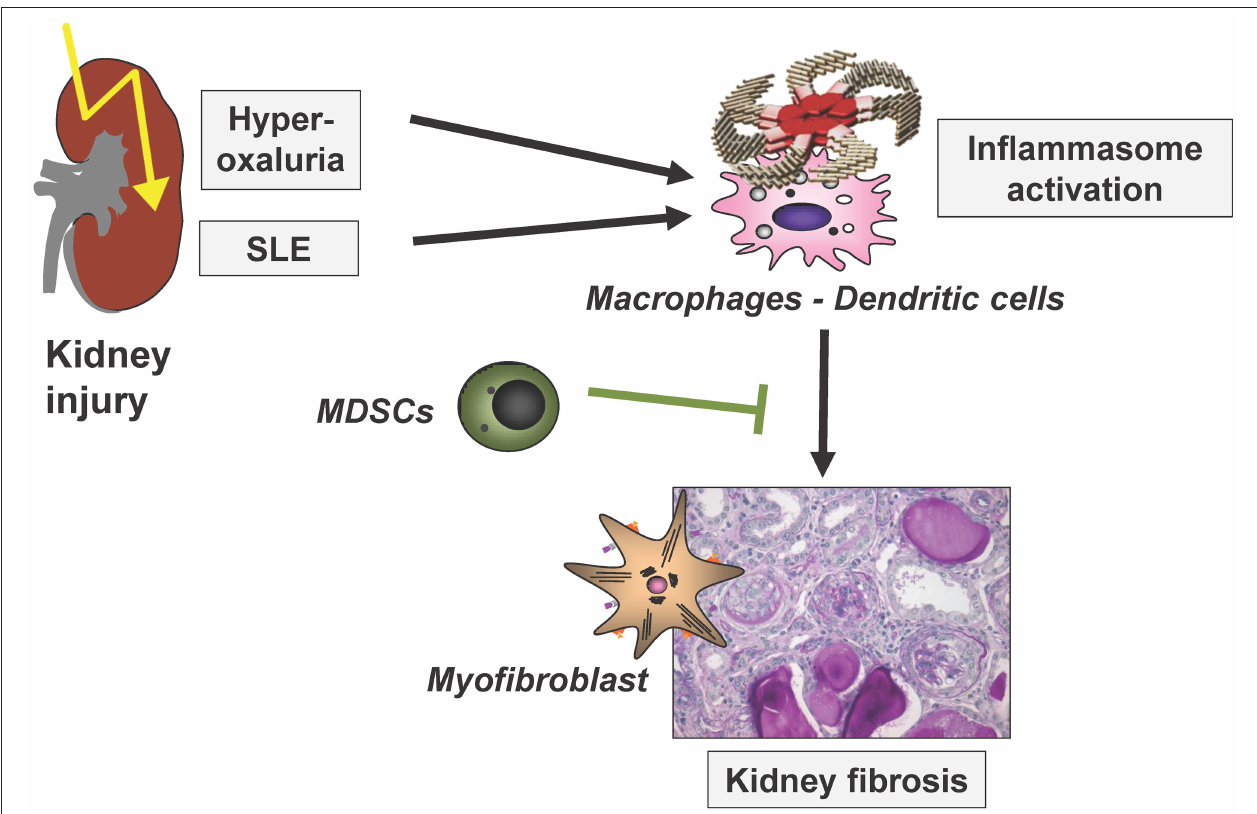
FIGURE 3 | Simplified scheme to illustrate renal inflammasome activation by two disease entities, finally leading to renal fibrosis. SLE, systemic lupus erythematosus; MDSCs, myeloid-derived suppressor cells. Modified based on (